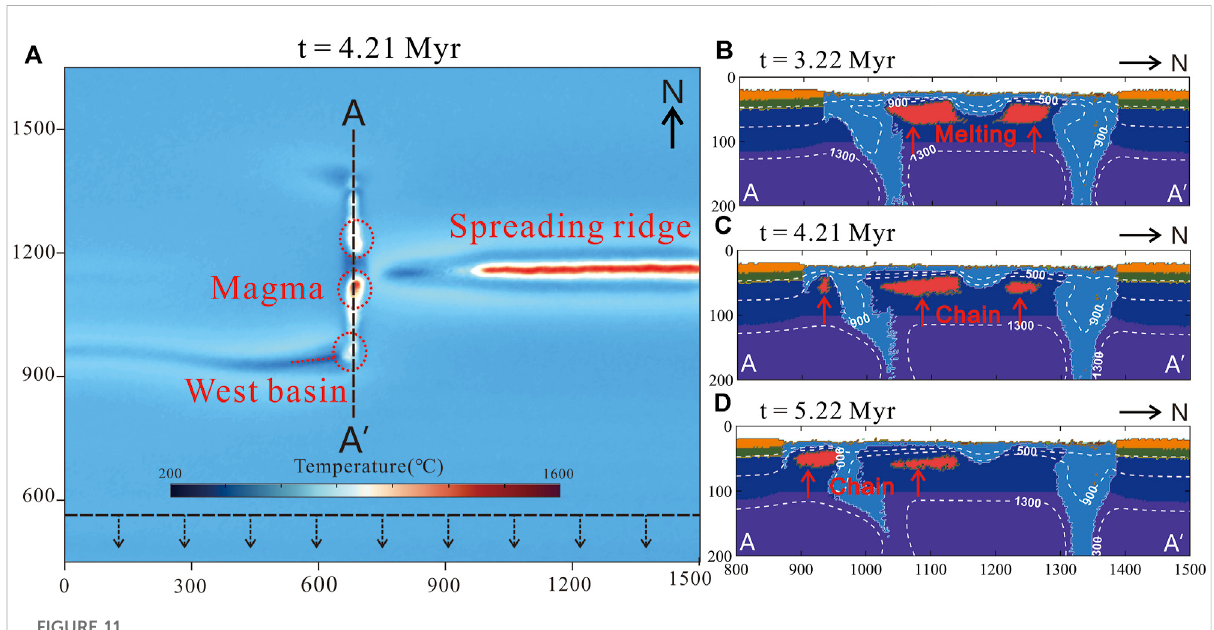
FIGURE 11 Formation of the volcanic chain along the strike of the transform fault. (A) Volcanic chain visualized by temperature shown in map view (B – D) Lithology snapshots showing the evolution of the volcanic chain along the AA ′ pro fi le. White dashed lines represent the